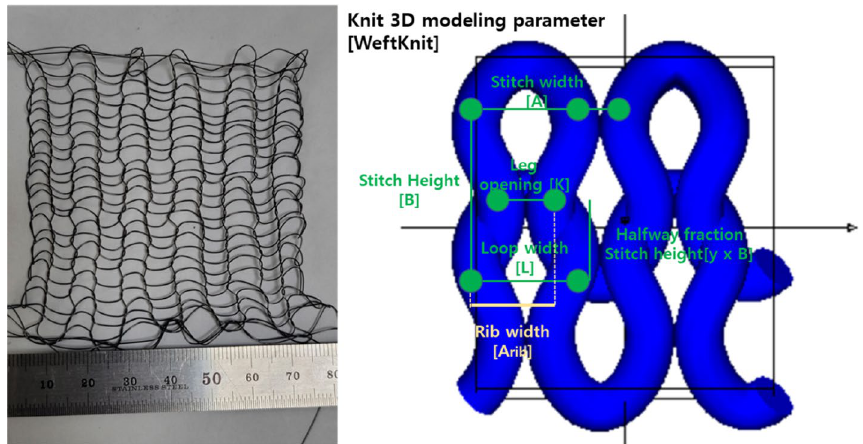
Fig. 1 Parameters of the knit unit cell structure and shape memory textile actuator